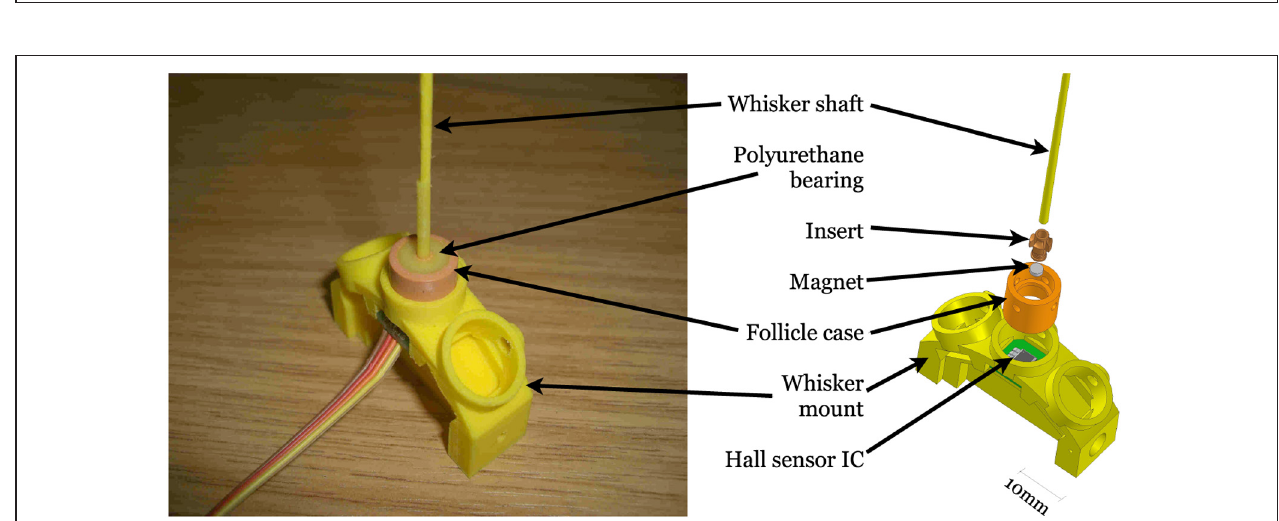
FIGURE 3 | Diagram of whisker follicle sensor construction. CrunchBot whisker follicles differ slightly in shape, but operate in exactly the same